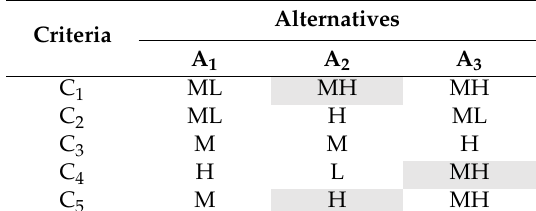
Table 10. Modified decision matrix.